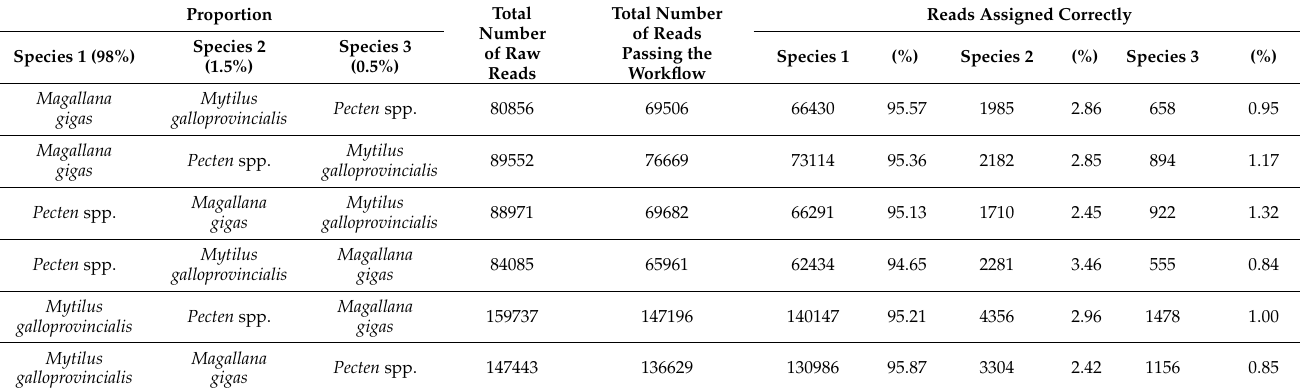
Table 4. Results for ternary DNA extract mixtures representing the three bivalve families of interest. DNA extracts (5 ng/ µ L) were mixed in a ratio of 98.0:1.5:0.5 ( v / v / v ). Numbers are mean values ( n = 9, three sequencing runs, three replicates per